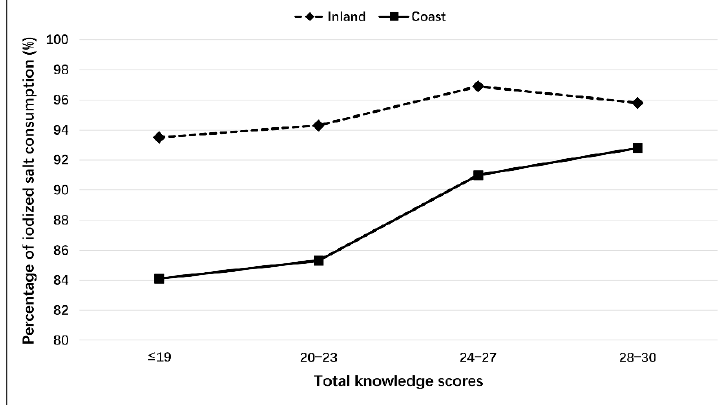
Figure 1. Percentage of iodized salt consumption according to knowledge scores and region.